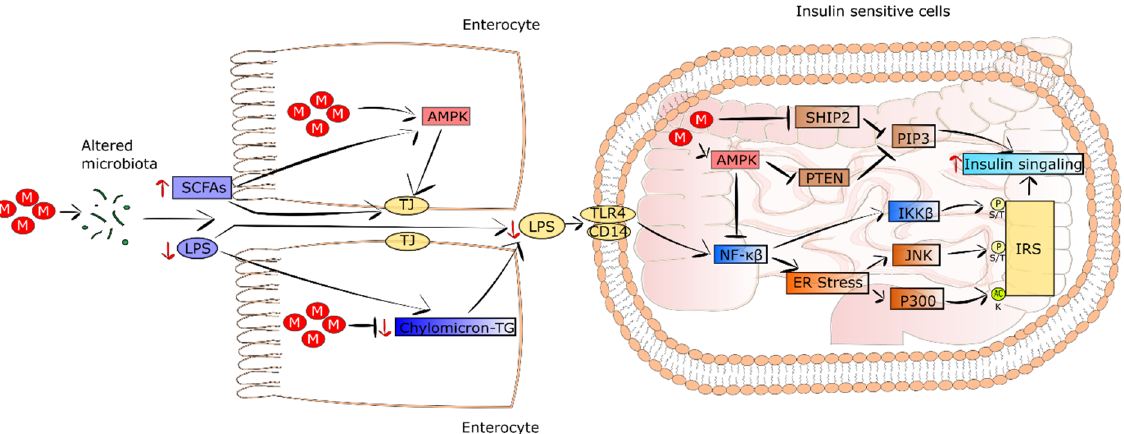
Figure 3. The improvement of systemic insulin sensitivity is a result of metformin-evoked microbiota alteration. In the intestine, the drug alters the microbiota composition, leading to reduced production of LPS and increased secretion of SCFAs. In turn, SCFAs and metformin-driven AMPK activation contribute to an improvement of the intestinal barrier, reducing the production of chylomicron, which in turn triggers a decreased level of LPS in circulation. In insulin-sensitive cells, the decreased level of LPS and low-grade inflammation lead to strengthening insulin signaling via decreased acetylation of IRS and phosphorylation of threonine and serine, as well as elevated PIP 3 levels. Abbreviations: M, metformin; SCFAs, short-chain fatty acids; LPS, lipopolysaccharides; TG, triglyceride; TJ, tight junction; AMPK, 5’ adenosine monophosphate-activated protein kinase; TLR4, Toll-like receptor 4; CD14, cluster of differentiation 14; NF- κ B, nuclear factor kappa-light-chain-enhancer of activated B cells; IKKB, inhibitor of nuclear factor kappa-B kinase subunit beta; SHIP2, SH2 domain-containing inositol 5-phosphatase 2; PIP3, phosphatidylinositol(3,4,5)triphosphate; PTEN, phosphatase and tensin homolog; ER, endoplasmic reticulum; JNK, c-Jun N-terminal kinase; IRS, insulin receptor.